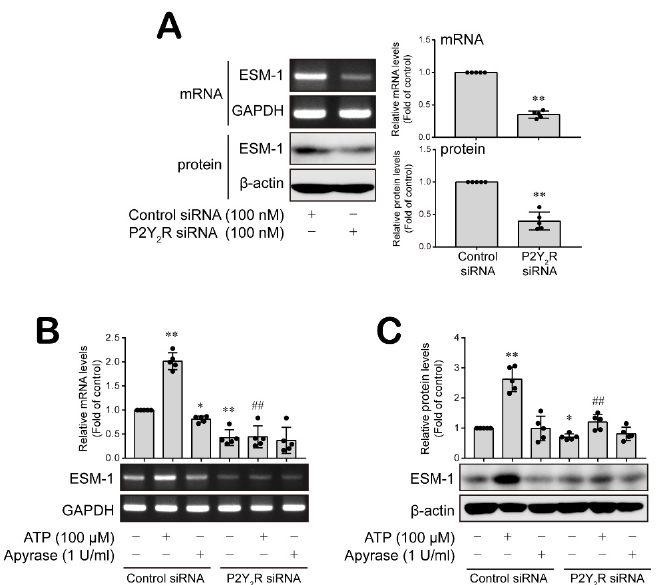
Figure 6. ATP-activated P2Y 2 R was involved in ESM-1 expression in RT-R-MDA-MB-231 cells. ( A ) After the efficiency of P2Y 2 R siRNA transfection was confirmed in RNA and protein level by RT-PCR and Western blotting, respectively ( A ), control or P2Y 2 R siRNA-transfected RT-R-MDA-MB-231 cells were treated with ATP (100 µM) or apyrase (1 U/mL; a highly active ATP-diphosphohydrolase) for 24 h ( B , C ). Total RNA and protein were collected from the cells, and ESM-1 mRNA ( B ) and protein ( C ) expression levels were analyzed by RT-PCR and Western blotting, respectively. GAPDH and β -actin were used as loading controls. The results are presented as the mean ± SD of five independent experiments. * p < 0.05, ** p < 0.01 compared to the control group in the control siRNA-transfected cells; ## p < 0.01 compared to the ATP-treated group in the control siRNA-transfected cells.